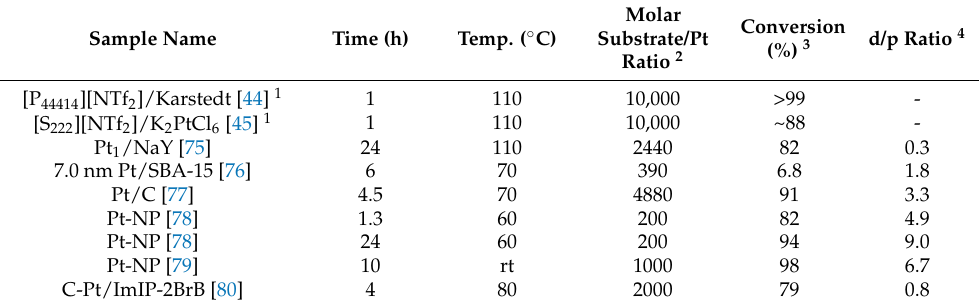
Table 6. Reference reactions for the catalytic hydrosilylation of phenylacetylene with triethylsilane 1